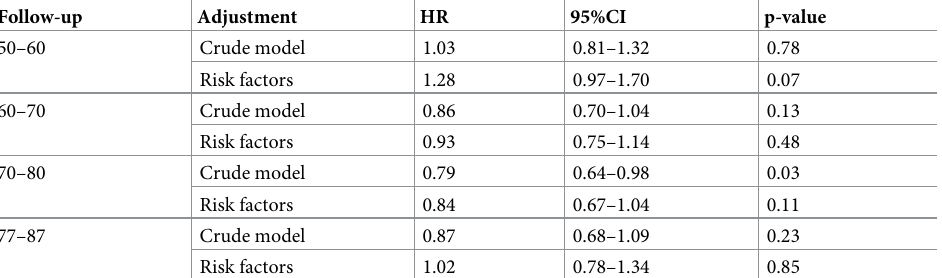
Table 2. Hazard ratio (HR) and 95%CI of physical activity (PA, trend test) for the combined end-point of cardio- vascular disease (CVD) when the 10-year risk was calculated among men free of previous CVD from each of the four investigation cycles in the ULSAM-cohort (performed at ages 50, 60, 70 and 77 years). Both the crude analysis and the analysis adjusted for traditional risk factors are shown.